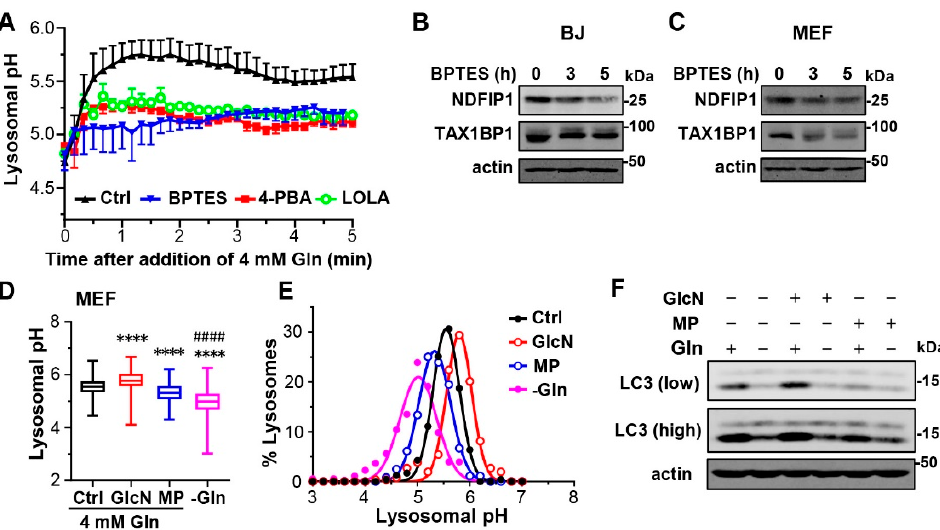
Figure 5. GLS1 inhibitor and ammonium scavengers attenuate glutamine effects on lysosomal pH and degradation. ( A ) Kinetics of lysosomal pH changes of L929 cells in response to the addition of Gln. FITC-dextran-loaded cells were cultured in Gln-free medium for 1 h before 2 mM Gln was added back. BPTES (20 µM), 4-PBA (10 mM), or LOLA (10 mM) was added after the chase of the dextran dye and allowed to incubate with the cells for 2 h (including the 1-h Gln starvation). Confocal ratiometric images were acquired at 10-s intervals immediately after the application of 2 mM Gln and continued for 5 min in an imaging chamber with the cells maintained live at 37 ◦ C. Data points are means ± SEM of n = 3 experiments, each representing average lysosomal pH values of 30–50 cells. ( B , C ) Western blot analysis of NDFIP1, TAX1BP1, and actin of BJ ( B ) and MEF ( C ) cells cultured in normal medium without or with BPTES (20 µ M) for 3 and 5 h as indicated. ( D ) Statistics of lysosomal pH of MEF cells maintained in normal culture medium supplemented with either glucosamine (GlcN, 10 mM) or methyl pyruvate (MP, 20 mM) as indicated, or in the Gln-free medium, based on quantification of 235 (Ctrl), 259 (GlcN), 360 (MP), 356 ( − Gln) individual lysosomes or lysosome clusters from 30–100 cells pooled from n = 3 experiments. **** p < 0.0001 vs. Ctrl, #### p < 0.0001 vs. either GlcN or MP, by one-way ANOVA with Tukey’s multiple comparisons test. ( E ) Gaussian distribution analysis of the same data from ( D ). ( F ) Western blot analysis of LC3 and actin of MEF cells cultured in normal medium supplemented with GlcN (10 mM) or MP (20 mM) as indicated in the presence or absence of Gln (4 mM). Low and high mean short and long exposures,